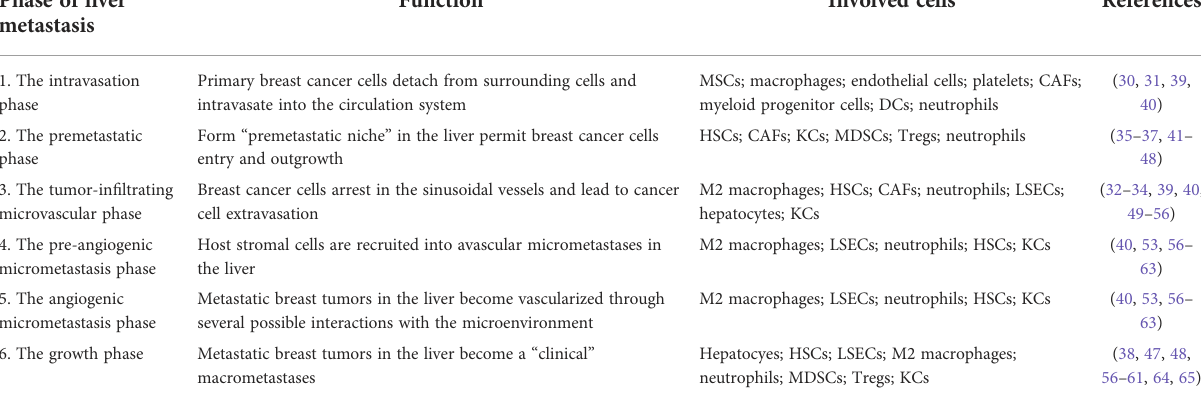
TABLE 1 The phases of breast cancer liver